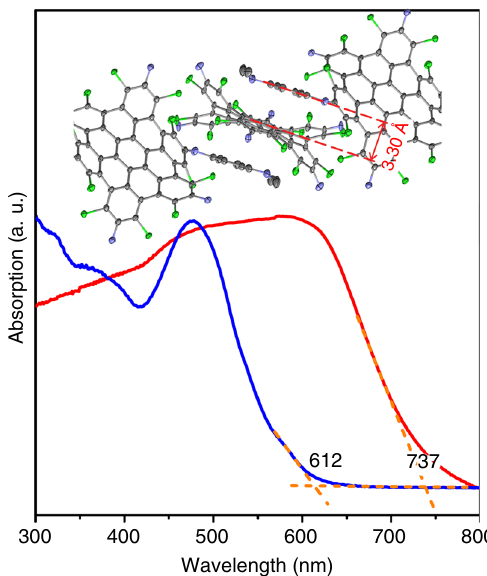
Fig. 3 Absorption and assembly in the solid state of 2e . The UV-Vis absorption of 2e in solid state (red) measured in a diffuse-re fl ectance mode was compared with that in dichloromethane (blue, 10 − 5 mol·L − 1 ). The peripheral groups which do not allow D – A interactions with the inner NG were omitted for